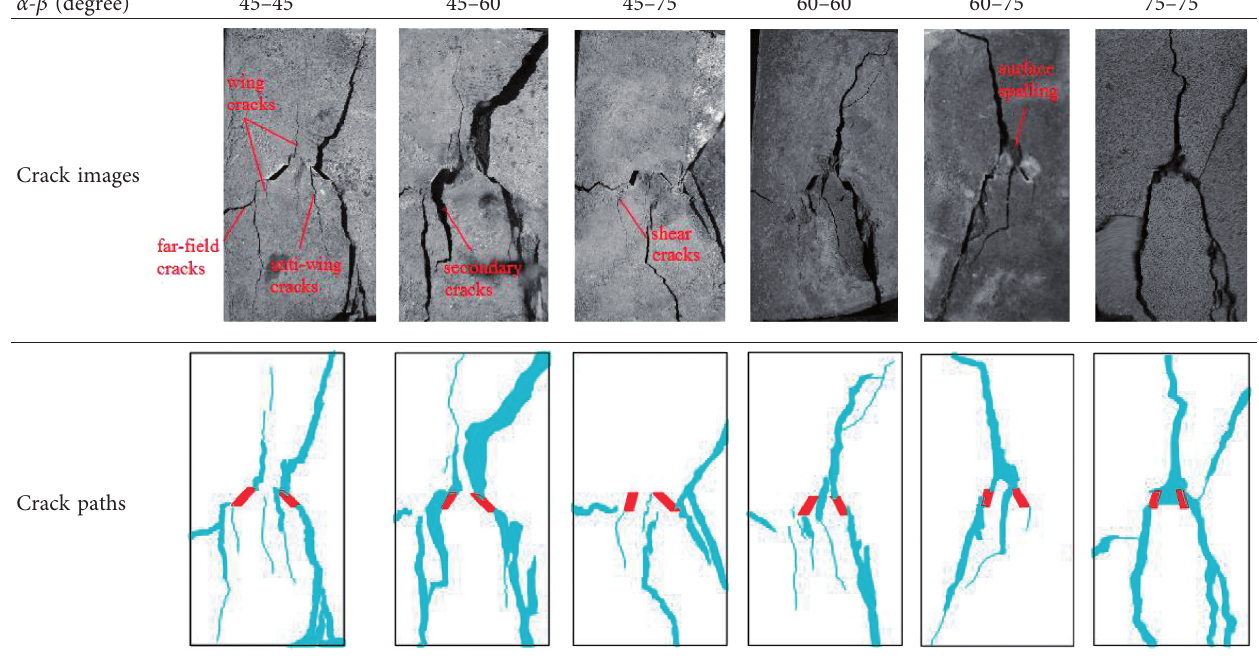
Table 5: Ultimate failure modes of the specimens containing two parallelogram flaws at different angles under uniaxial compression. α - β